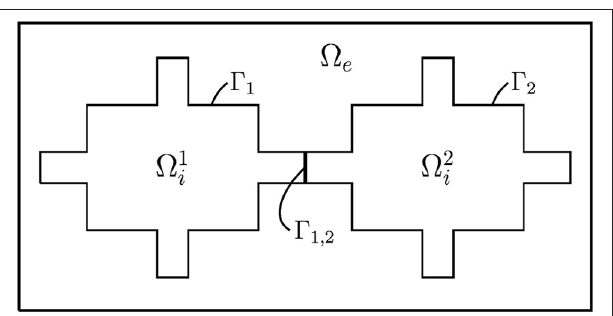
FIGURE 1 | Illustration of an idealized computational domain: two idealized cells (cid:127) 1 i and (cid:127) 2 i connected by a gap junction Ŵ 1,2 and the surrounding extracellular domain (cid:127) e .